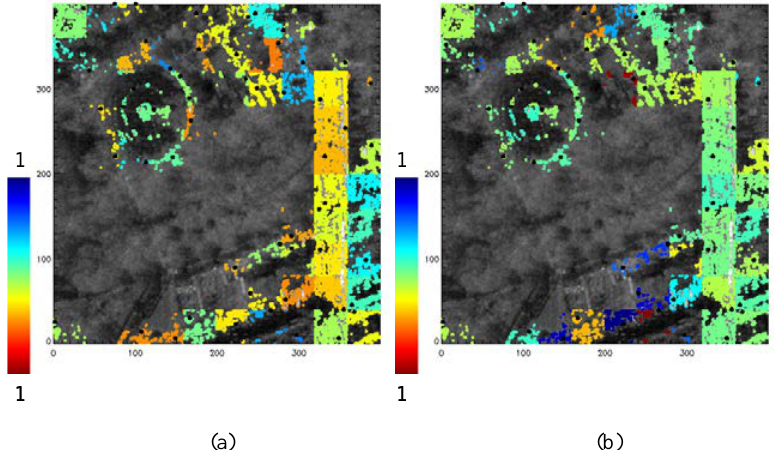
Figure 6: Residual DEM estimation results using the newly developed technique. (a) Estimates of local slopes of residual DEM in range (x) direction in m/pixel. (b) Estimates of local slopes of residual DEM in azimuth (y) direction in